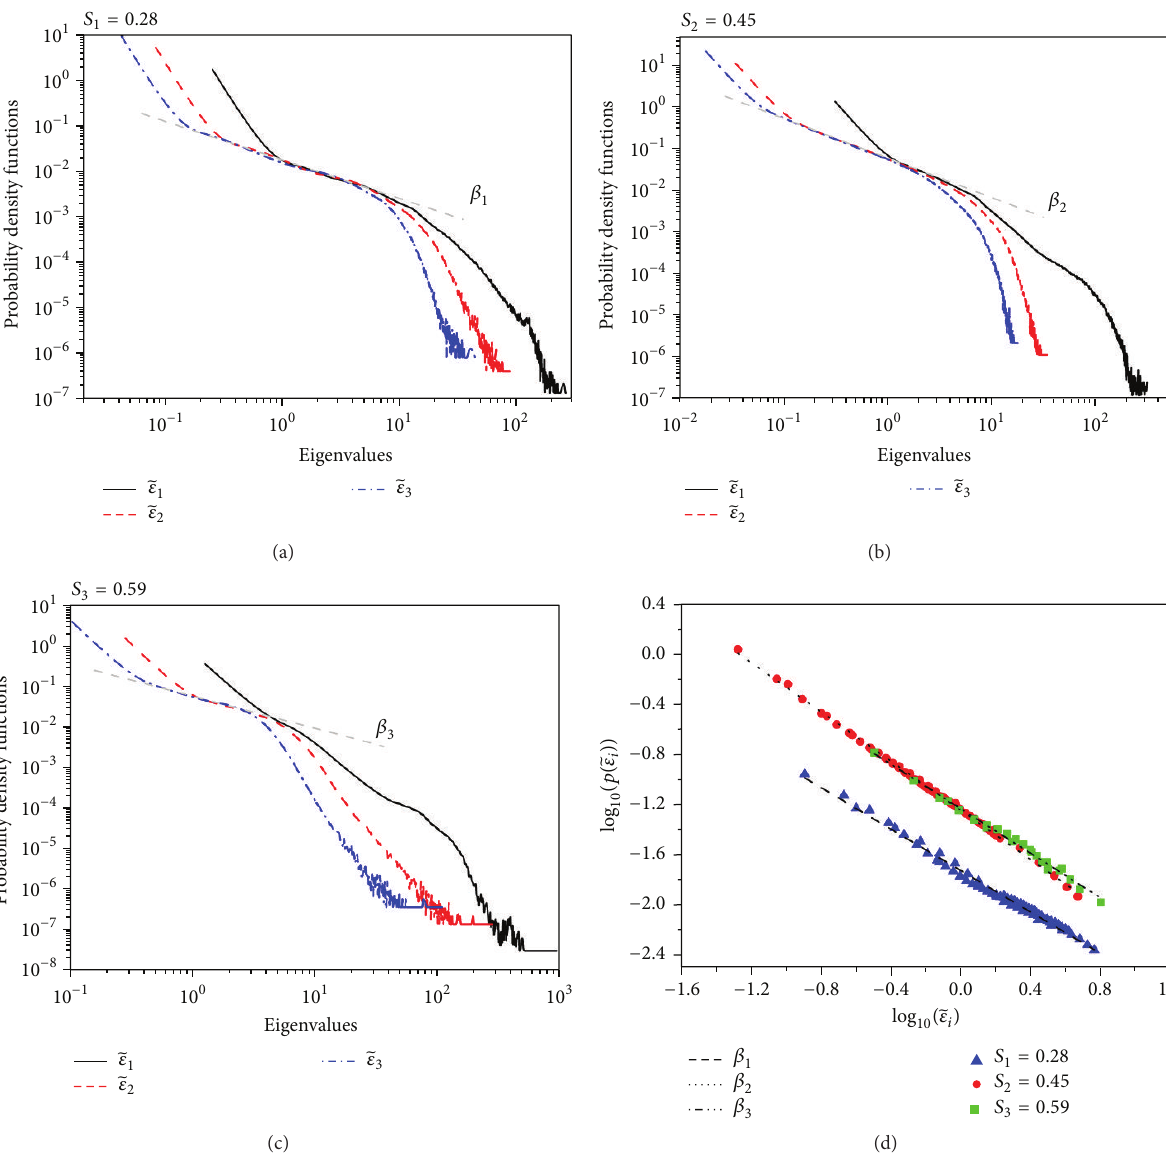
combined distributions (̃𝜀 𝑖 , ̃𝜀 𝑗 ) (e.g., (̃𝜀 1 , ̃𝜀 3 ) and (̃𝜀 2 , ̃𝜀 3 ) ), the probability density function 𝑝(̃𝜀 𝑖 ) (PDF) of one eigenvalue ̃𝜀 throughout the flow domain; that is, 𝑝(̃𝜀 𝑖 ) = ∫ 𝑝(̃𝜀 𝑖 , ̃𝜀 𝑗 )𝑑̃𝜀 𝑗 . In general, PDF is defined as the concentration or density 𝛿𝑛(̃𝜀 𝑖